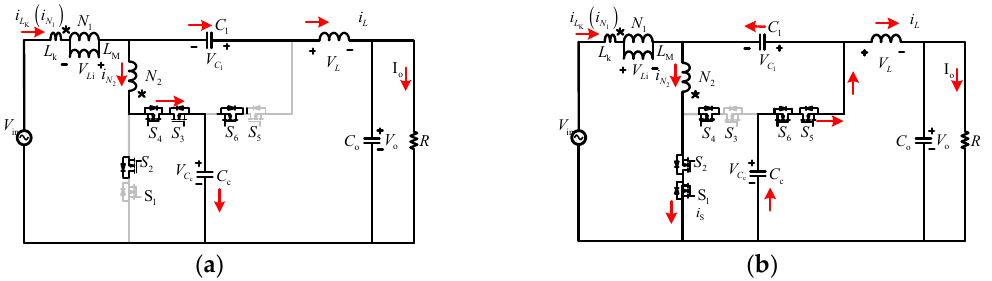
Figure 5. Effect of N on voltage gain.